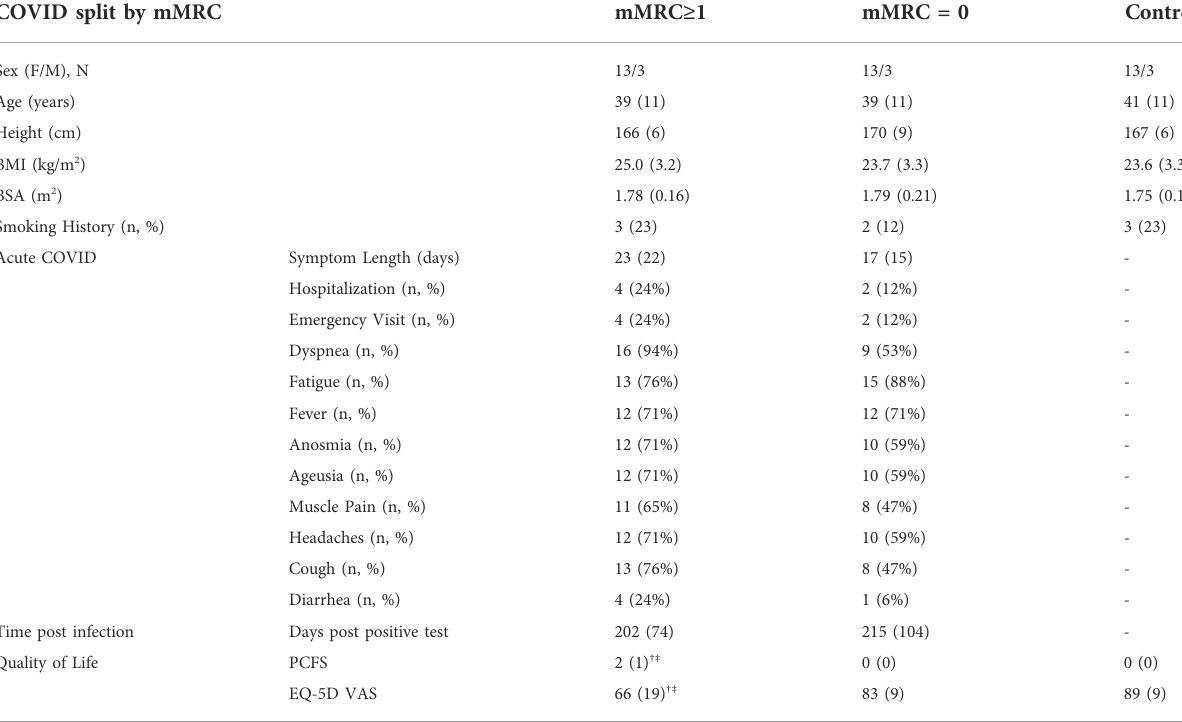
TABLE 2 Participant characteristics, symptoms during acute infection, and time since molecular con fi rmed positive COVID-19 test for COVID-19 groupsafterstrati fi cationbymMRCdyspneagrade(0=normal, ≥ 1=dyspneic)andControls.BMI,bodymassindex;BSA,bodysurfacearea;PCFS, Post-COVID Functional Scale; EQ-5D VAS, EuroQol 5-Dimension visual analog scale. COVID split by